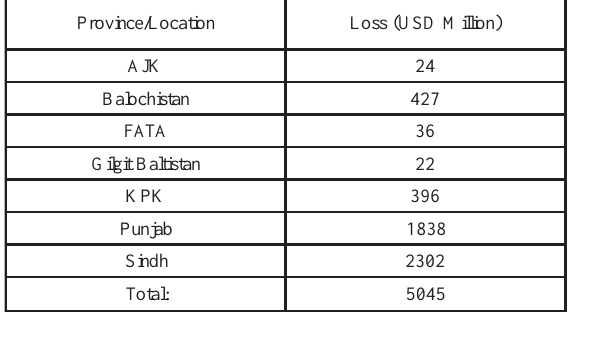
TABLE 3. AGRICULTURE SECTOR LOSS DUE TO 2011 FLOOD IN